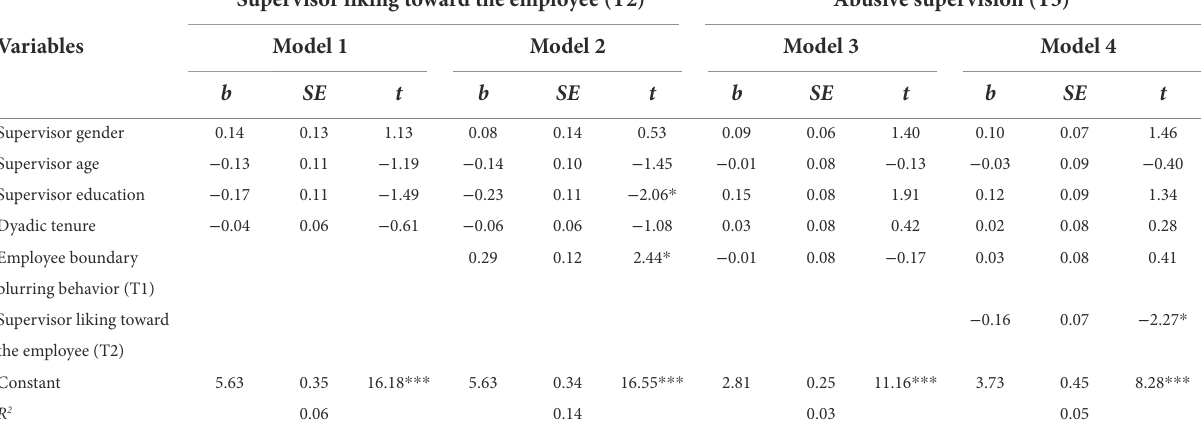
TABLE 4 The effects of employee boundary blurring behavior and supervisor liking toward the employee on abusive supervision in Study 2.